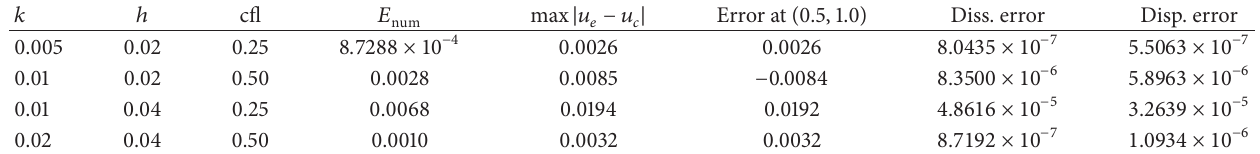
Table 3: Errors for NSFD